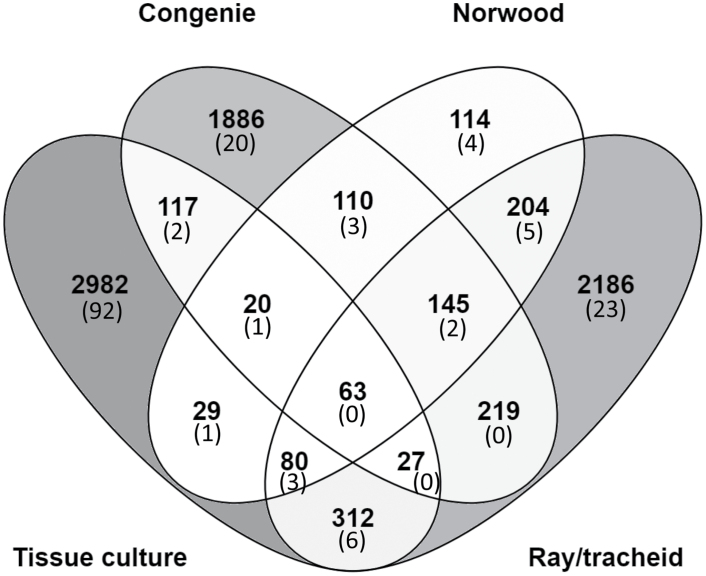
Venn diagram representing genes whose expression correlated with the bait genes in four different datasets: Tissue culture (Laitinen et al., 2017), ConGenIE (Nystedt et al., 2013), Norwood (Jokipii-Lukkari et al., 2017), and Ray-tracheid (Blokhina et al., 2019). The number of ABC, MATE, and MFS transporters is given in parentheses.